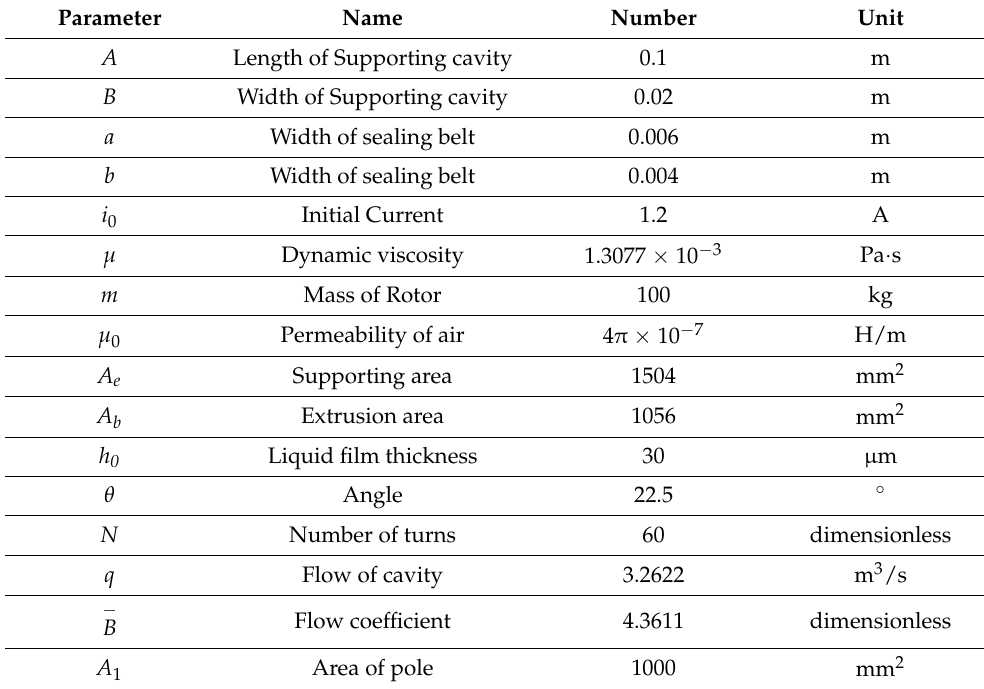
Table 2. Design parameters of